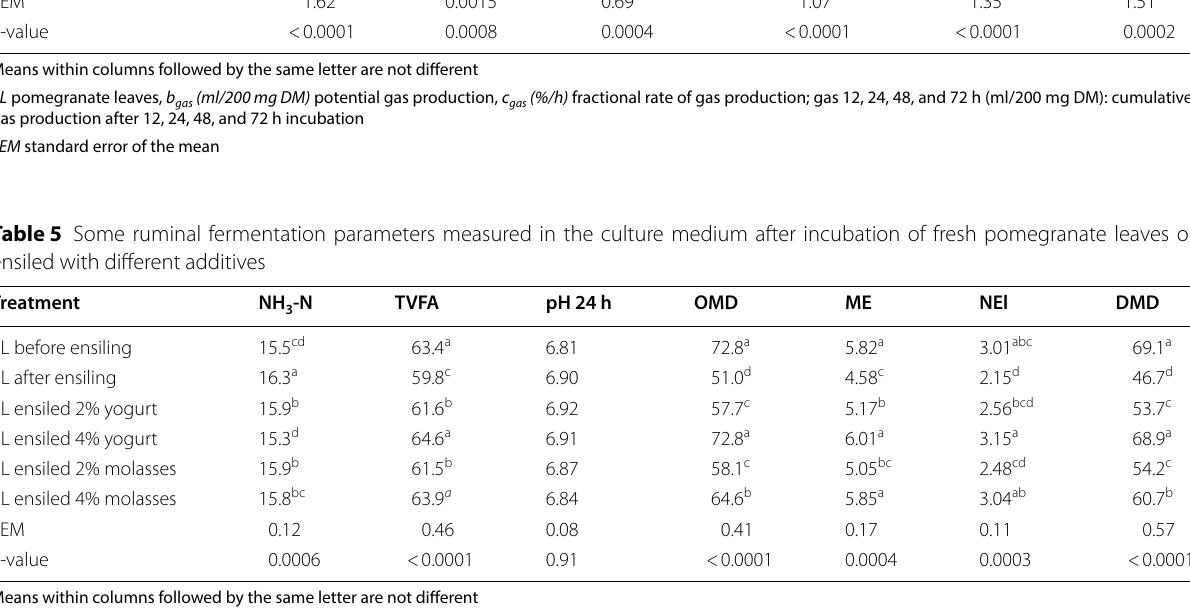
Means within columns followed by the same letter are not different OMD and DMD were determined after 24 h incubation PL pomegranate leaves, NH 3 -N (mg/dL) : ammonia nitrogen, TVFA (mmol/L) total volatile fatty acid, OMD (%) organic matter digestibility, ME (MJ/kg DM) metabolizable energy, NEl (MJ/kg DM) net energy for lactation, DMD (%) dry matter digestibility SEM standard error of the mean